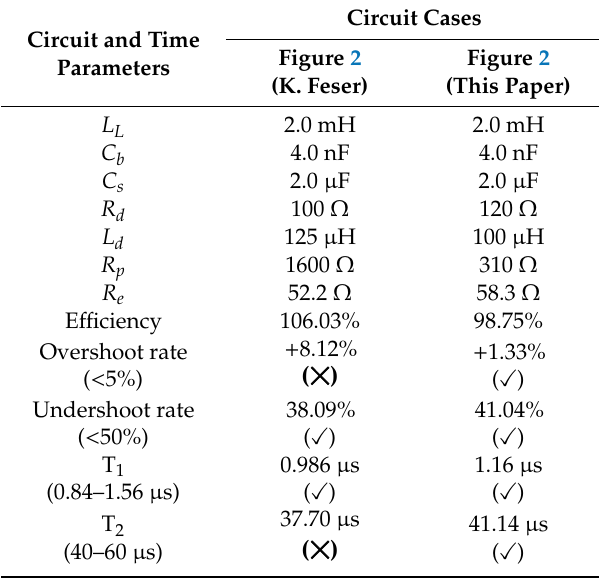
Figure 2. Generated waveforms using the conventional circuit. Table 2. Circuit parameters in the Glaninger’s generation circuits and waveforms parameters of the generated waveforms. Table 1. Circuit parameters in the conventional lightning impulse voltage generation circuits and waveforms parameters of the generated waveforms.